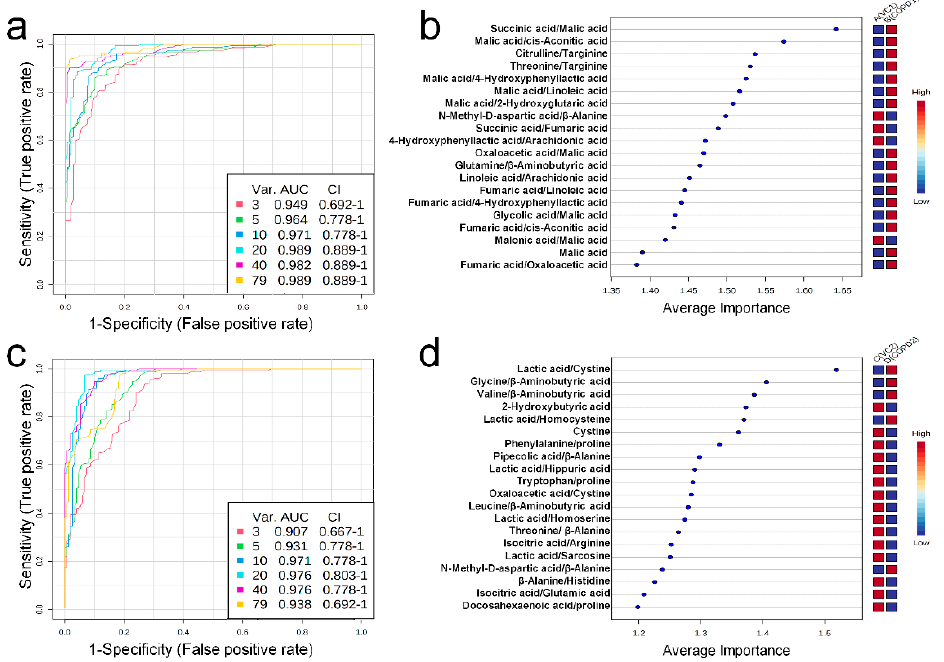
Figure 4. Multivariate ROC curve analysis ( a ), average importance of metabolite combinations of 20 types in multivariate ROC curve analysis ( b ) of urine in COPD1 and VC1 groups. Multivariate ROC curve analysis ( c ), average importance of metabolite combinations of 20 types in multivariate ROC curve analysis ( d ) of urine in COPD2 and VC2 groups.